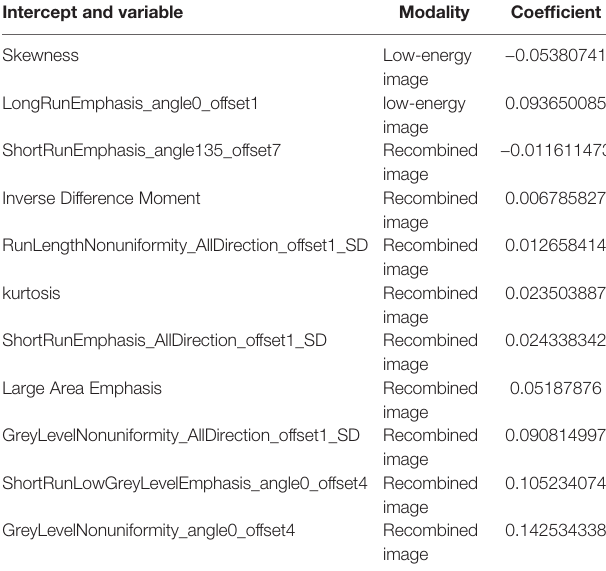
TABLE 2 | Radiomics feature for establishing radiomics